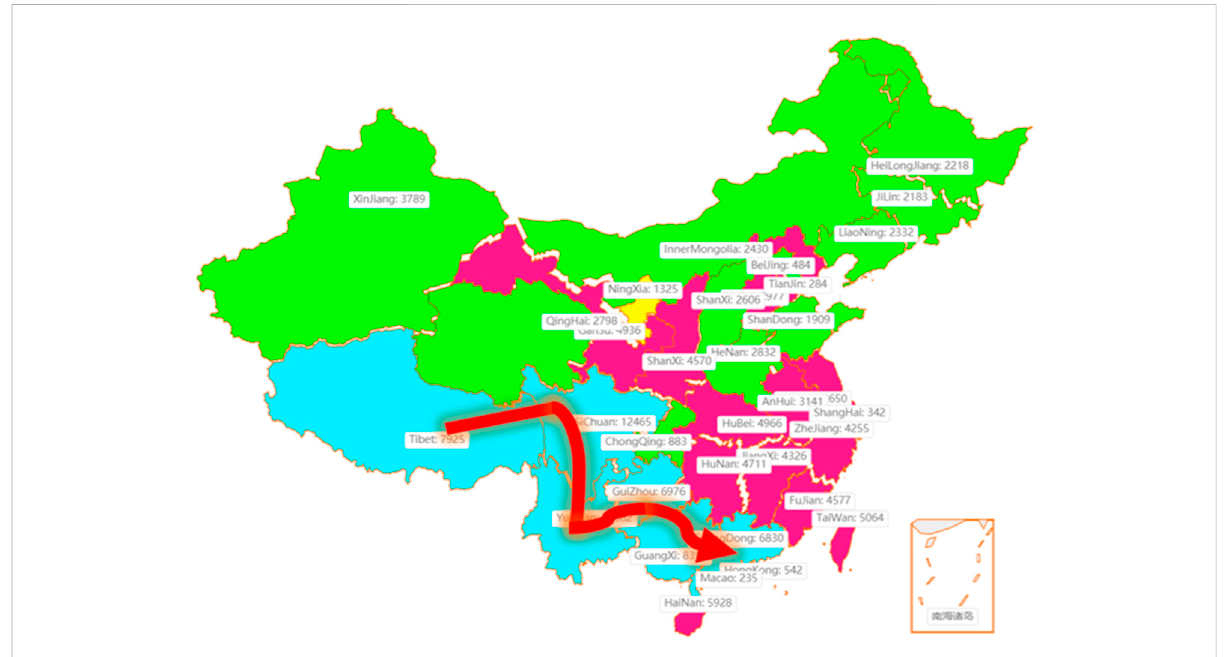
FIGURE 9 Main migration routes of plants from west to